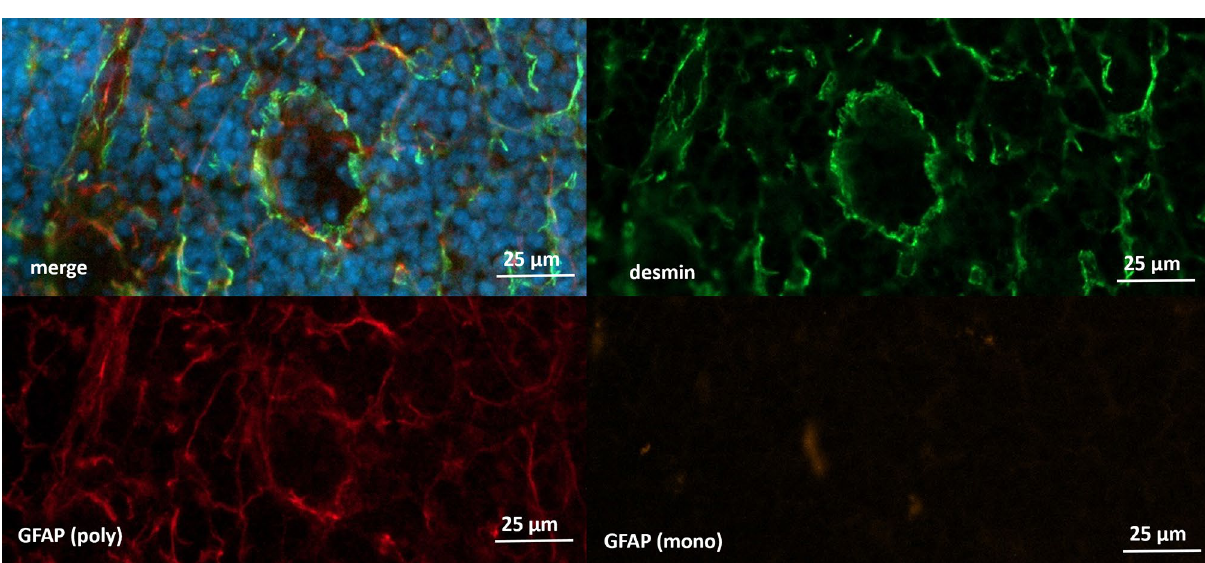
Figure 9. Immunhistochemical staining of cervical lymph node (cortical area) with polyclonal anti-GFAP antibody (red), monoclonal anti-GFAP antibody (orange) and desmin (green). DAPI for nuclear staining in blue. No signal with monoclonal GFAP could be found in the area of the